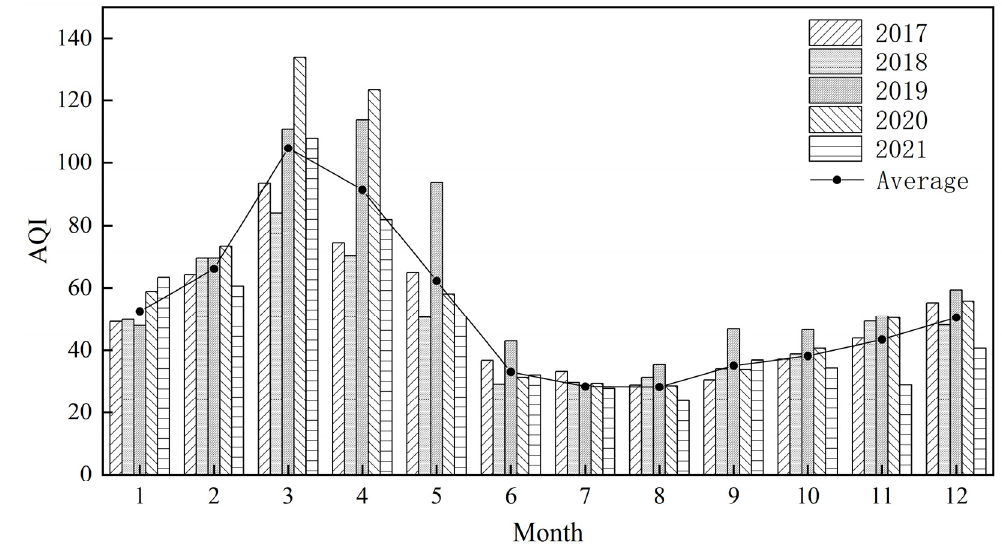
Figure 1. Monthly average values of Jinghong’s AQI from 2017 to 2021.